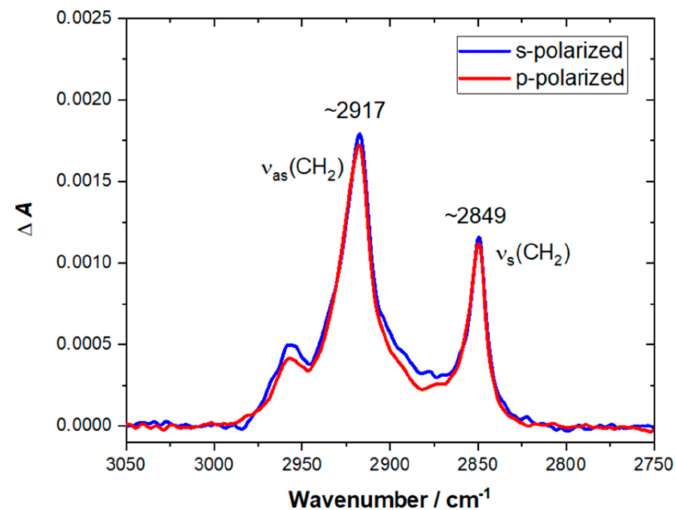
Figure 4. C–H stretching region of attenuated total reflection Fourier-transform infrared spectroscopy (ATR-FTIR) spectra recorded for DPPG/POPG/CL bilayer on Si prism after 90 min of lipid film deposition and washing the cell with pure buffer solution. The spectra were recorded in 0.01 M PBS dissolved in D 2 O. The red line corresponds to the spectrum recorded with p-polarized light, while the blue line corresponds to the spectrum recorded with s-polarized